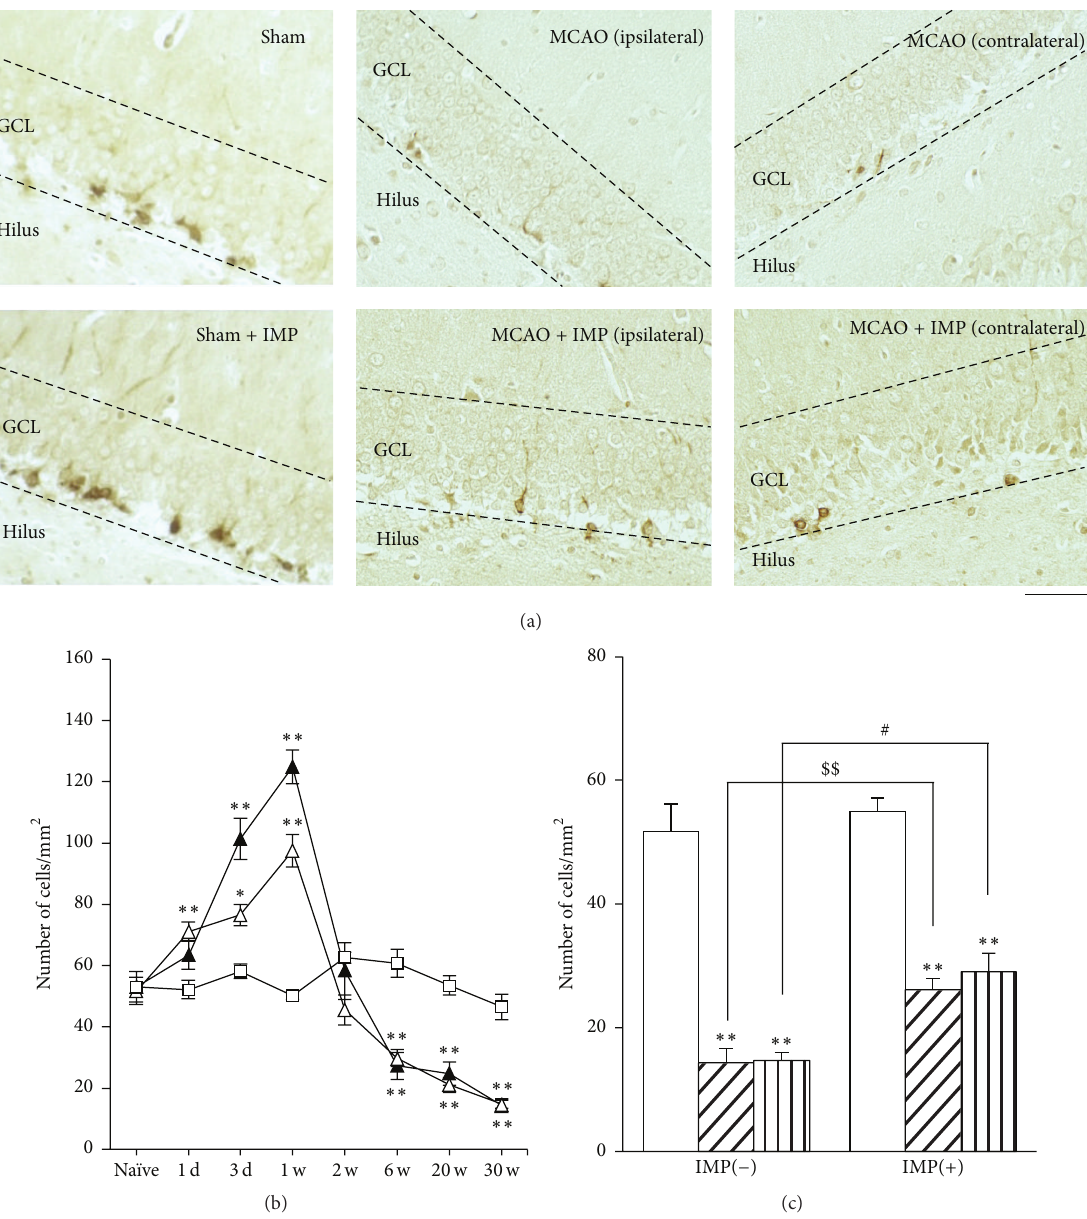
Figure 13: Analysis of DCX immunopositive cells in GCL. (a) Typical images of the slices taken at 30 weeks after MCAO. Scale bar indicates 50 𝜇 m. (b) Time course changes of DCX immunopositive cells after MCAO in GCL. Symbols used are as follows: open square, sham; closed triangle, ipsilateral MCAO; open triangle, contralateral MCAO. Statistical significance was evaluated with one-way ANOVA followed by = 80.7 ; 𝐹 = 5.91 ; 𝐹 = 22.7 ; ∗∗ 𝑃 < 0.01 versus sham; # 𝑃 < 0.05 versus Tukey-Kramer test at each time point ( 𝐹 ( ( group )2 ( time ∗ group )14,96 time )7 contralateral MCAO [IMP( − )]; 𝑁 = 5 /group). (c) Analysis of the effect of imipramine (IMP) on the number of DCX immunopositive cells at 30 weeks after MCAO. Vehicle [IMP( − )] or 20 mg/kg/day of IMP for 29 weeks [IMP(+)] from 1 week after the surgical operation was administered. Statistical significance was evaluated with one-way ANOVA followed by Tukey-Kramer test ( 𝐹 5,24 = 41.60 ; ∗∗ 𝑃 < 0.01 versus sham; # 𝑃 < 0.05 versus contralateral MCAO [IMP( − )]; 𝑁 = 5 /group). Unpaired 𝑡 -test was performed with ipsilateral MCAO [IMP( − )] versus [IMP(+)] ( 𝑡 = −4.10 , $$ 𝑃 < 0.01 ).